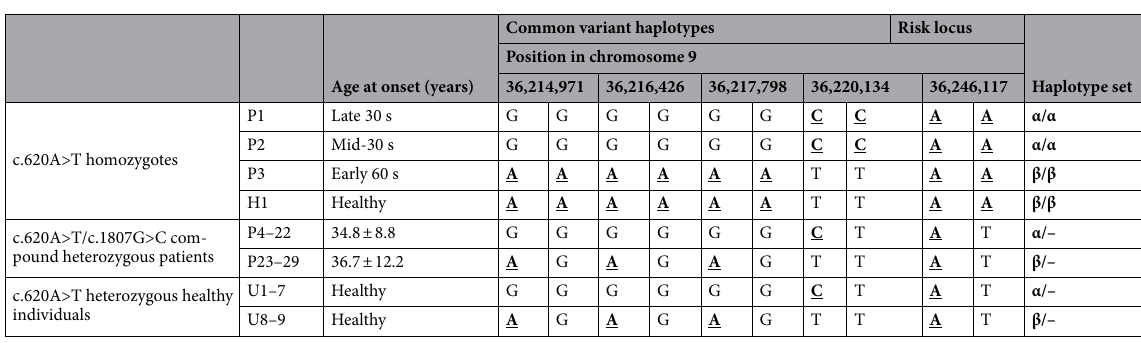
Table 1. Two haplotypes harboring GNE c.620A>T. Bases altered from the reference sequence are underlined and in bold. P1–3: three patients homozygous for c.620A>T. H1: healthy individual homozygous for c.620A>T. P4–13: ten patients with compound heterozygous c.620A>T/c.1807G>C alleles. U1–9: individuals carrying c.620A>T from public data (U1–6 from the Biobank Japan Database, U7–9 from the Nagahama cohort study).